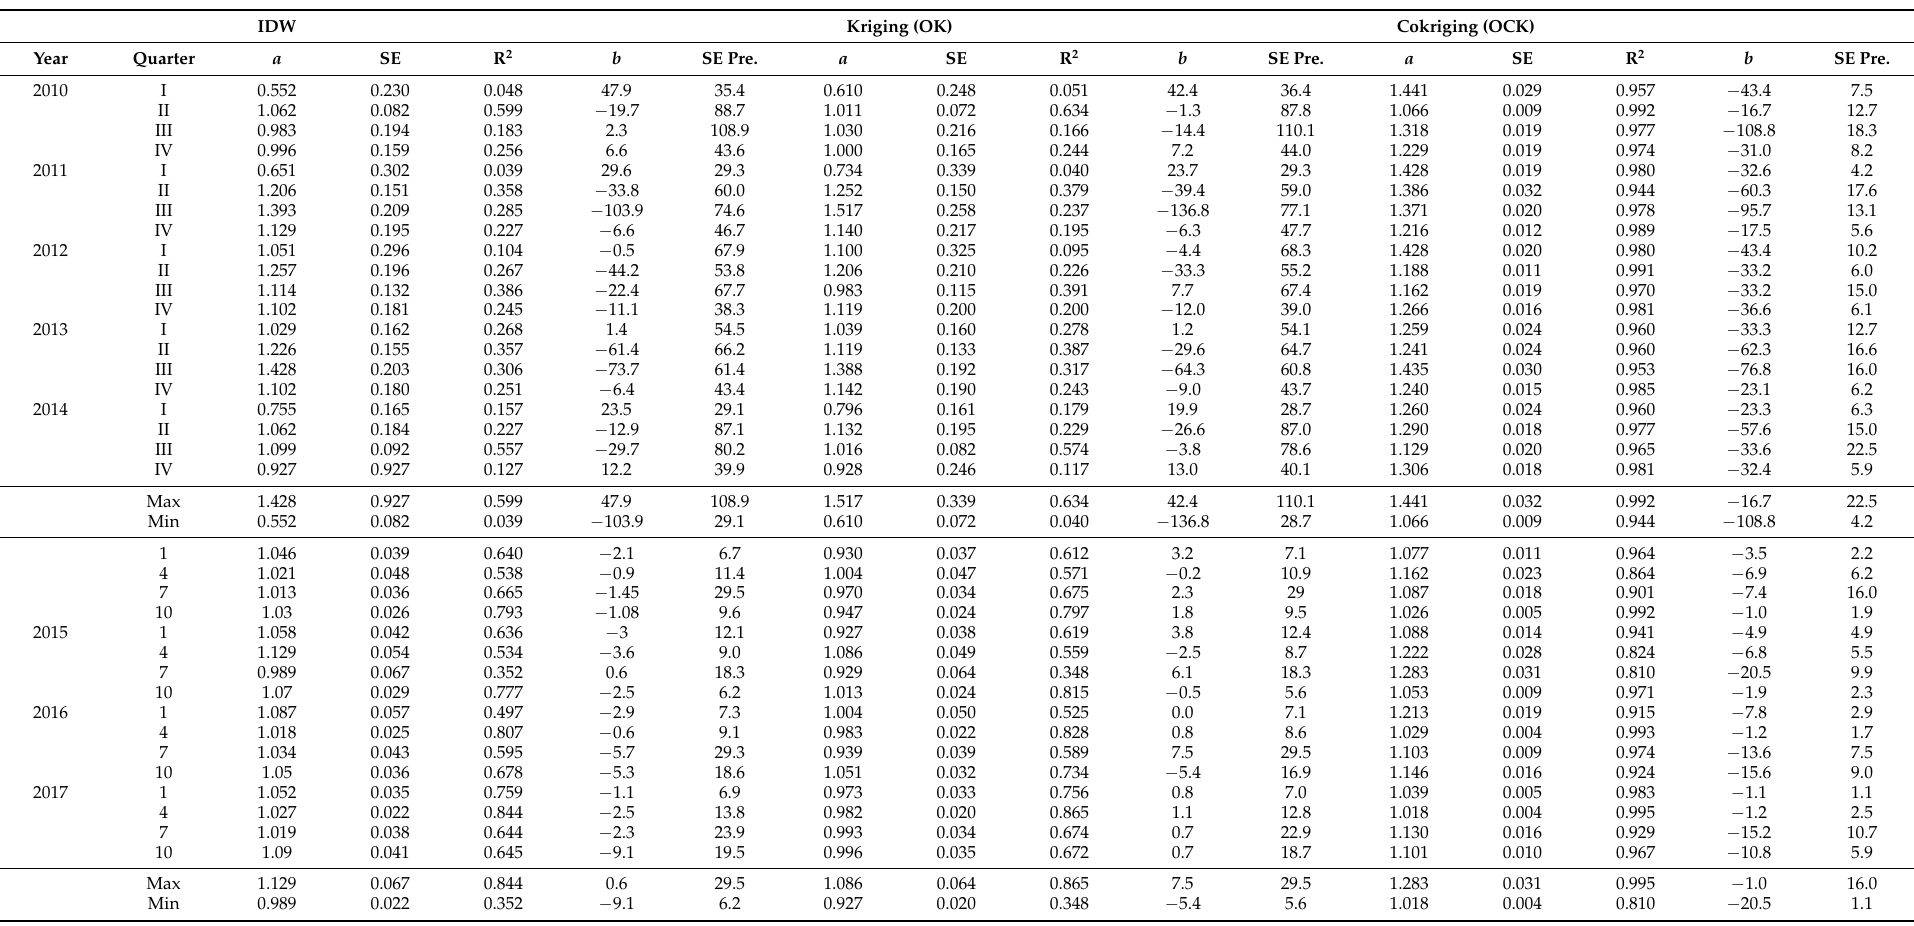
Table 4. Performance of inverse distance weighting (IDW), ordinary kriging (OK), and ordinary cokriging (OCK) for estimation of quarterly rainfall in Poland and neighbouring